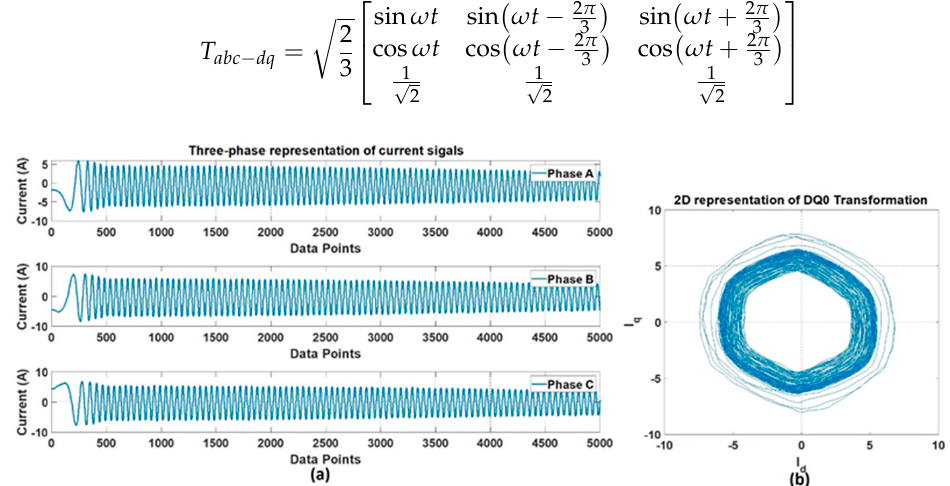
Figure 9. (a) Three-phase current signal, and (b) DQ0 representation. Figure 9. ( a ) Three-phase current signal, and ( b ) DQ0